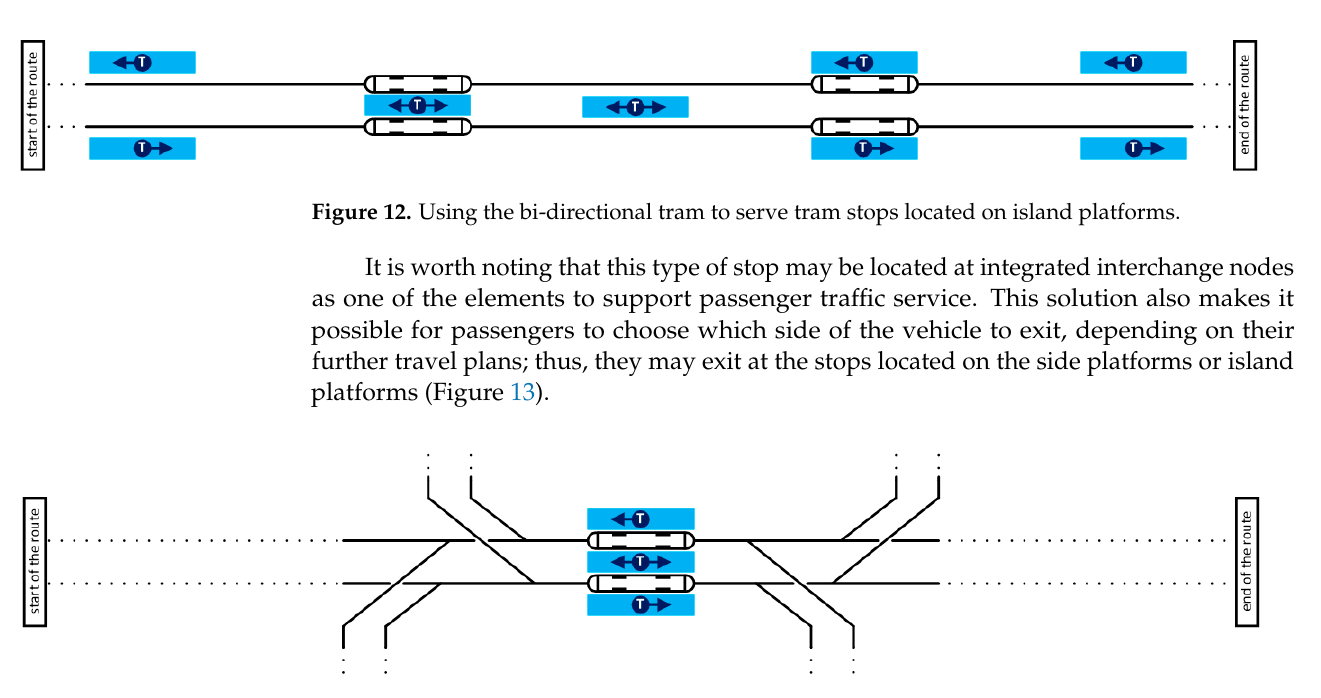
Figure 13. Using the bi-directional tram to serve tram stops located on side or island platforms.